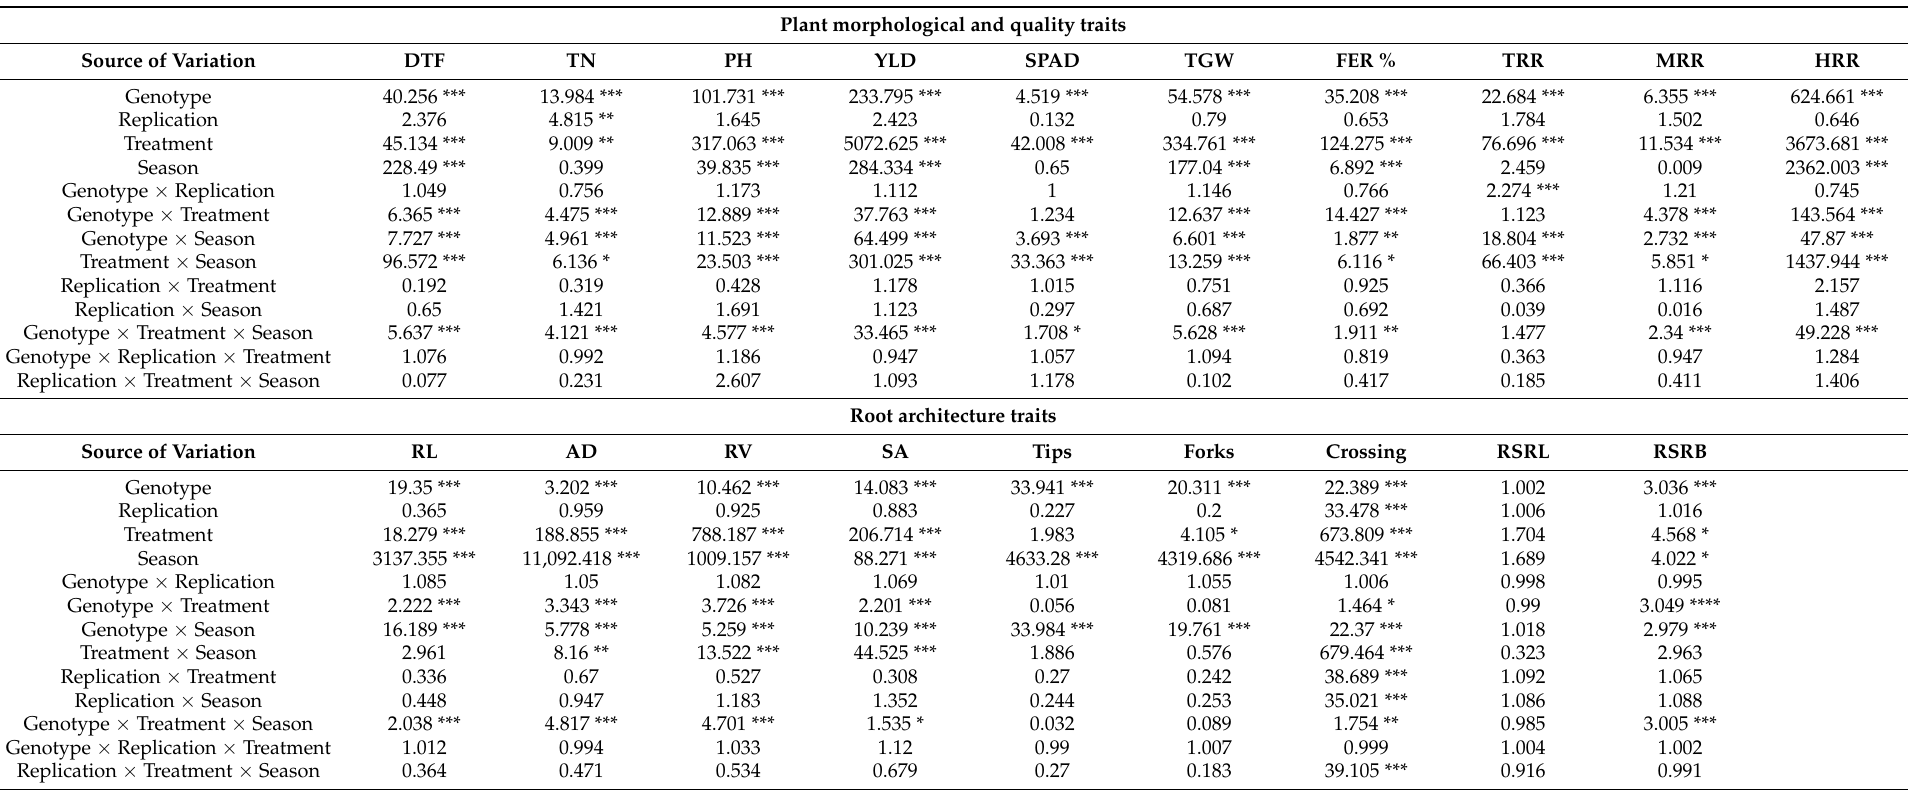
Table 2. Analysis of variance (ANOVA) for plant morphological, grain quality and root architecture traits under direct seeded and transplanted puddled system of rice